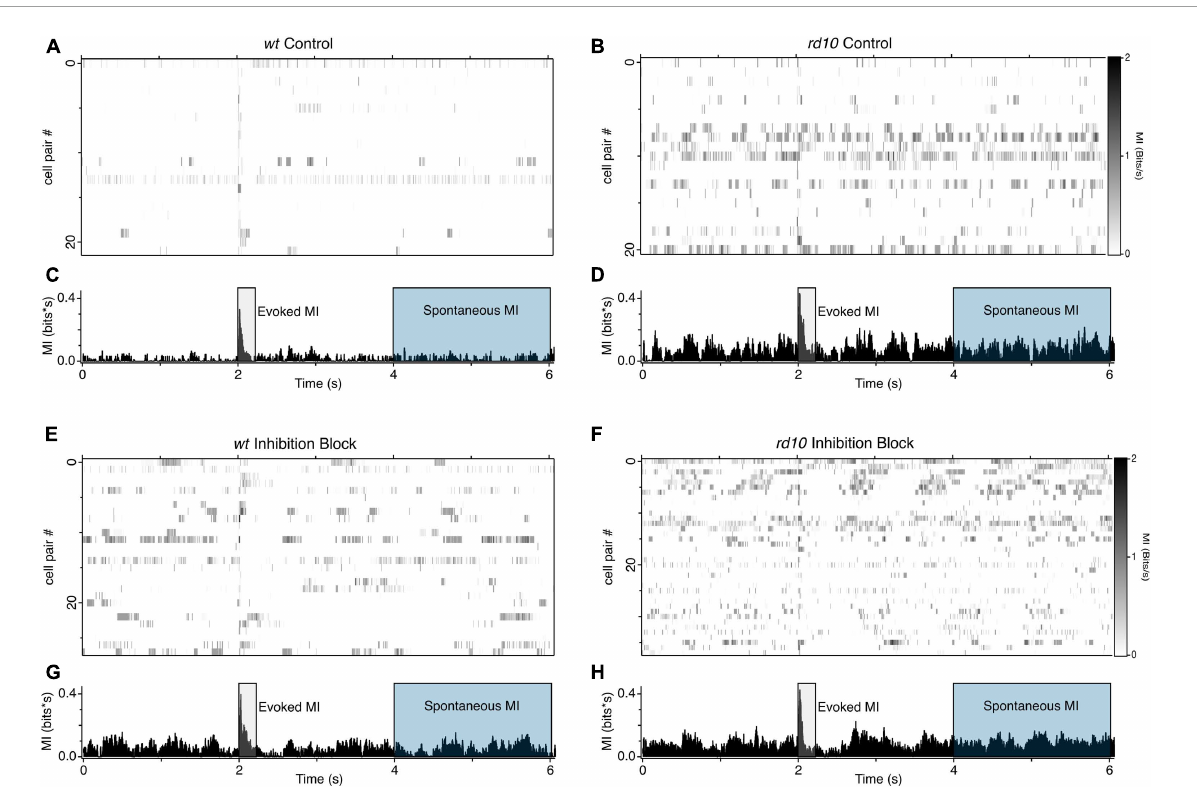
FIGURE4 Patterns of MI between RGC pairs (A) Heatmaps of MI between RGC pairs for wt ( n = 22) and (B) rd10 ( n = 21). (C,D) Histograms showing the averaged binned MI for all RHC pairs shown in the heatmap above. (E–H) Same as (A–D) , but during inhibition block (5 µ M SR-95531, 50 µ M TPMPA, and 5 µ M strychnine). wt ( n = 28), rd10 ( n = 38). A 20 nC, 1 ms per phase, biphasic stimulation was delivered at time 2 s. Shaded regions show time periods used to integrate evoked and spontaneous